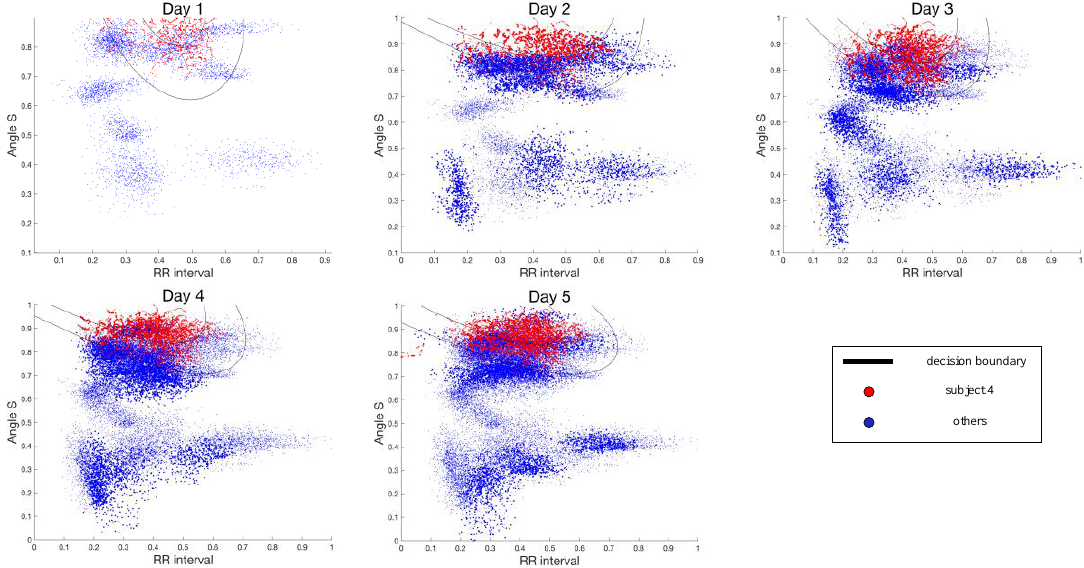
Figure 10. Updating decision boundary of incremental SVM for subject 4 data set over five-day incremental learning. The darker dots from days 2 to 5 represent the incrementally trained data.